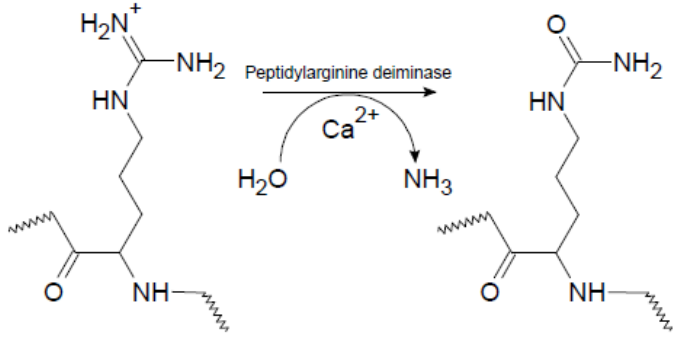
Figure 1. Citrullination (deimination) of peptidylarginine catalyzed by peptidylarginine deiminase in a calcium-dependent process. The positively charged guanidino group is replaced with the neutral ureido group.